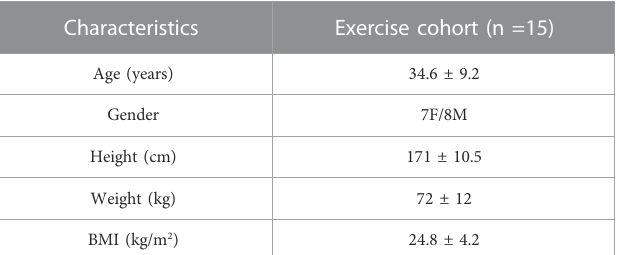
TABLE 1 Characteristics of the 15 participants of the movement